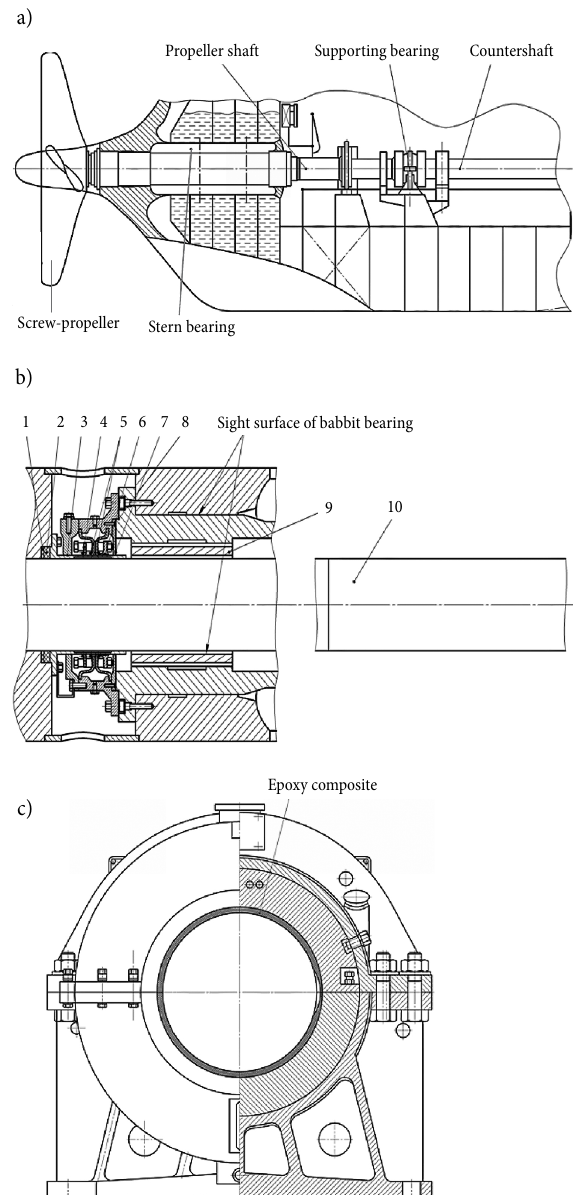
Fig. 9. Renewal and replacement of structural elements with epoxy composites: a – general scheme of shafting; b – stern bearing; c – thrust bearing of intermediate shaft; 1 – adjusting ring at the point of the screw; 2 – rubber rings; 3 – aft